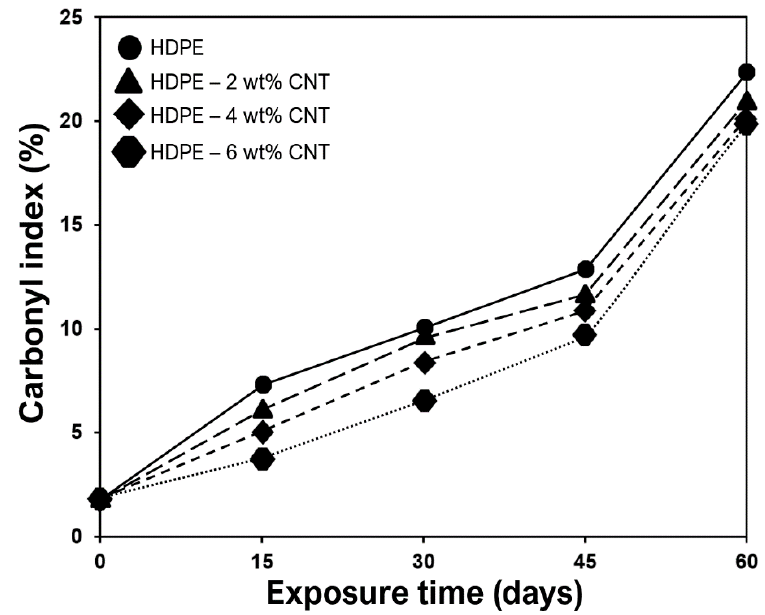
Figure 6. Carbonyl indices ( I CO ) of the monolithic and nanocomposite films exposed to UV-B radiation.